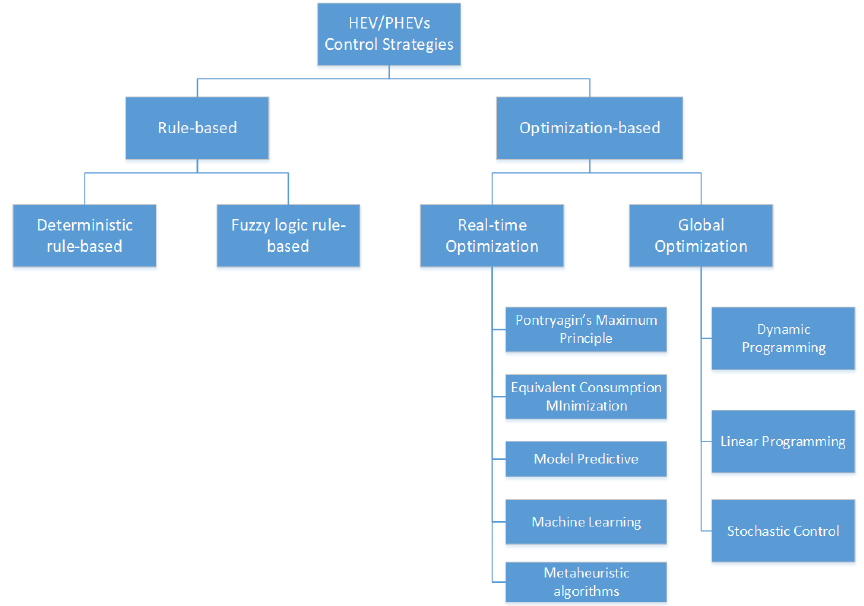
Figure 7. Classification of HEV/PHEV control strategies